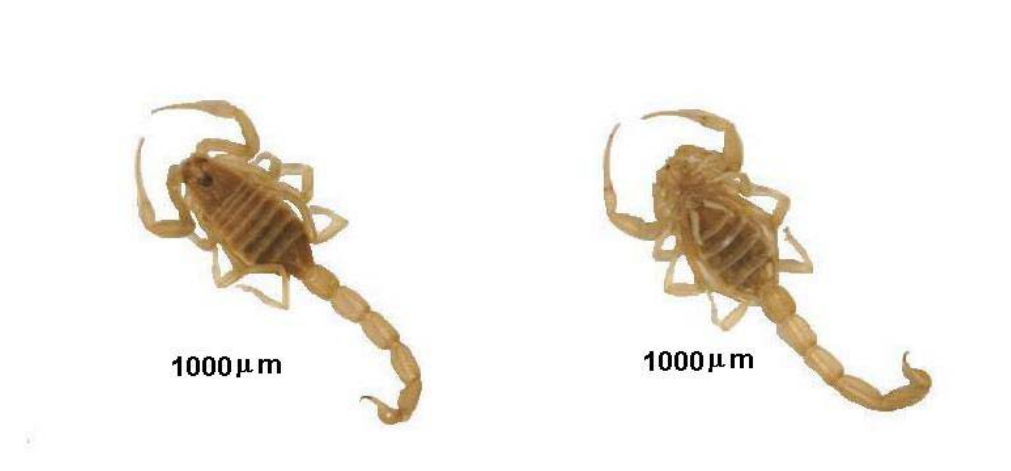
Figure 4. Compsobuthus arabicus collected in the Riyadh region.